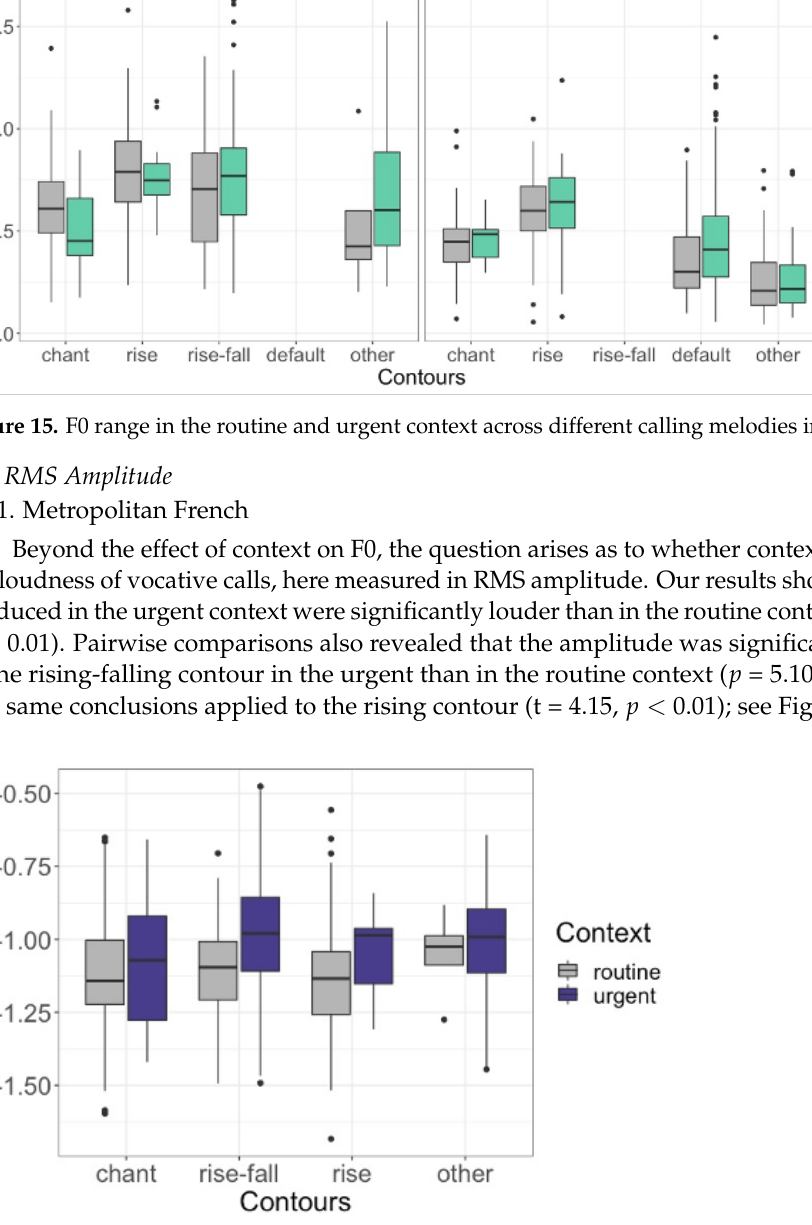
Figure 16. RMS amplitude in the routine and urgent context across different calling melodies in